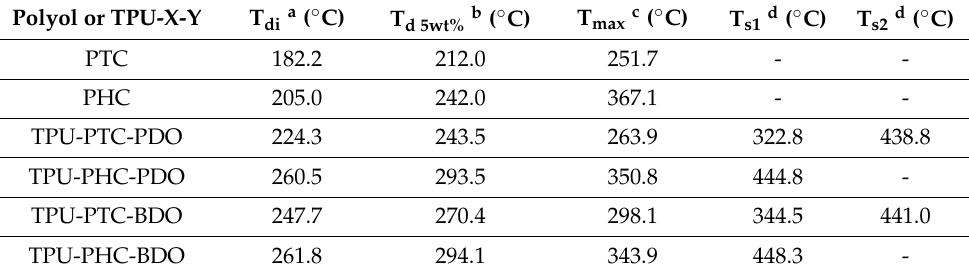
Figure 6. Decomposition curves of ( a ) TPU ‐ TG, ( b ) TPU ‐ DTG, ( c ) polyols ‐ TG, and ( d ) polyols ‐ DTG. Table 4. Characteristic temperatures of decomposition.